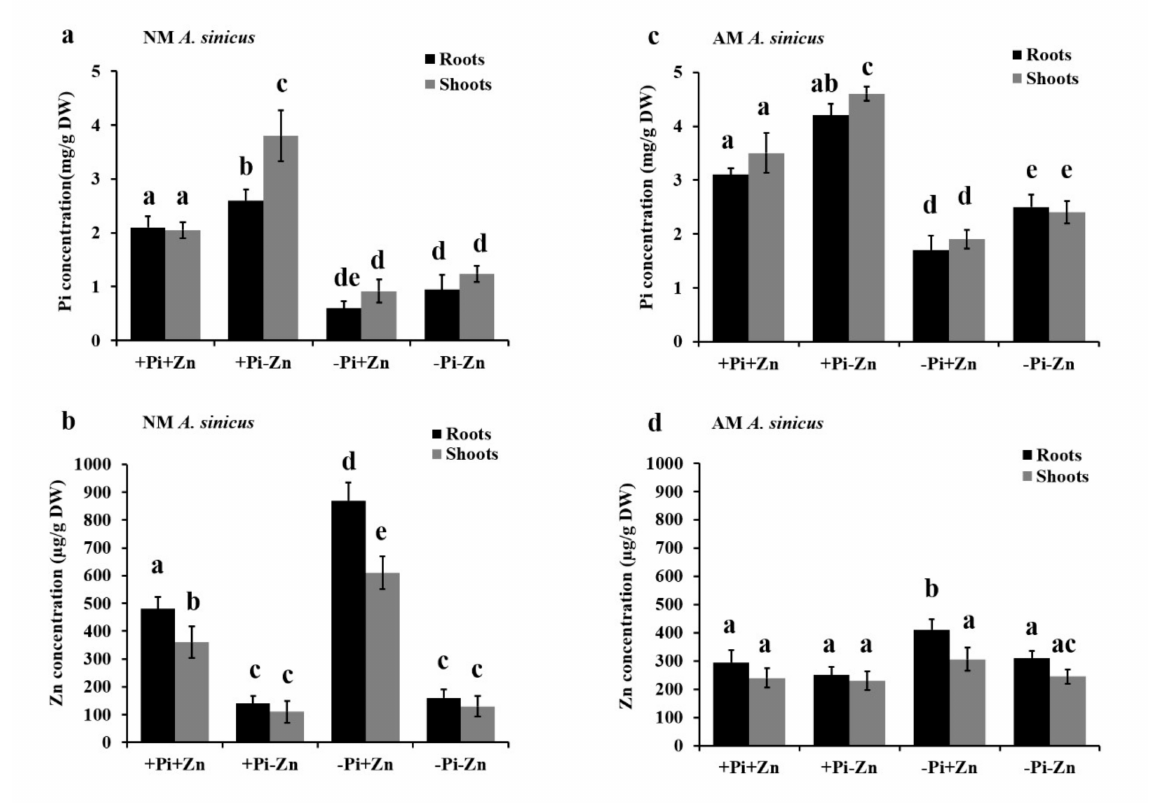
Figure 1. Physiological analysis of phosphorus and zinc interaction in A. sinicus plants. A. sinicus plants were grown in pot cultures treated with 300 µ M Pi and 50 µ M Zn (+Pi+Zn), 300 µ M Pi and 0.5 µ M Zn (+Pi-Zn), 30 µ M Pi and 50 µ M Zn (-Pi+Zn) or 30 µ M Pi and 0.5 µ M Zn (-Pi-Zn). Pi and Zn concentrations were quantified in roots (black) and shoots (gray) of 56-d-old NM ( a , b ) or AM ( c , d ) plants. A. sinicus roots colonized by R. irregularis at 42 dpi. ( a , c ) Total P concentration in A. sinicus ; ( b , d ) Zn concentration in A. sinicus . Error bars indicate the standard deviation from three biological replicates. The different letters are statistically significant differences among treatments at p < 0.05, based on Duncan’s multiple range test. DW, Dry